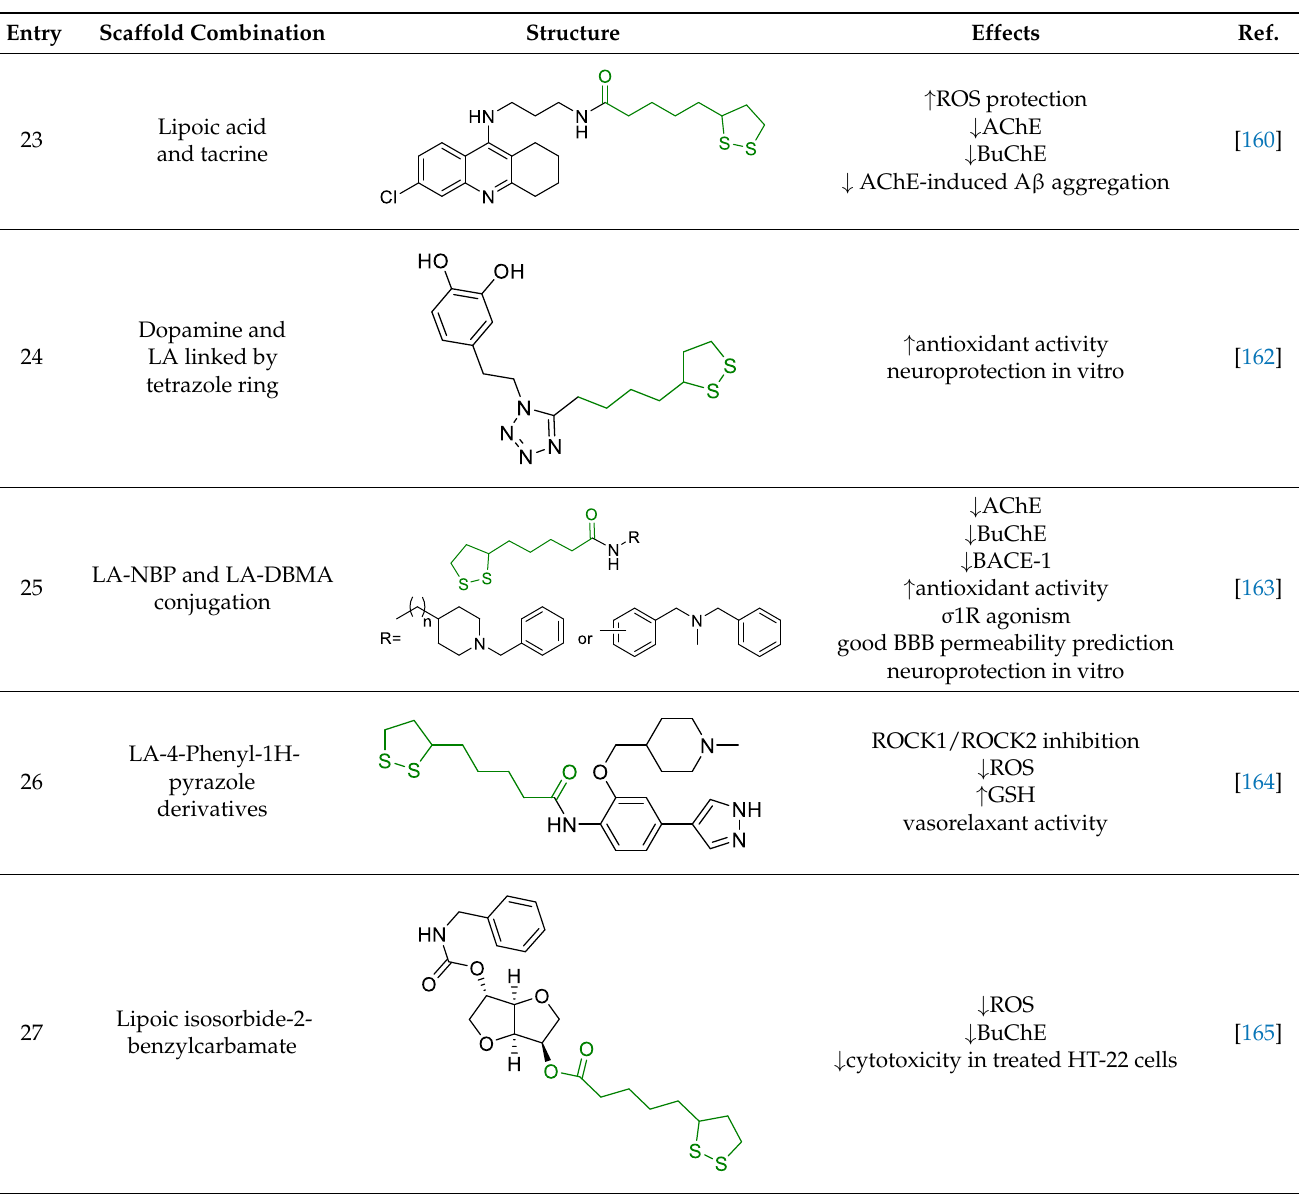
Table 5. Lipoic acid hybrids and their main biological effects.